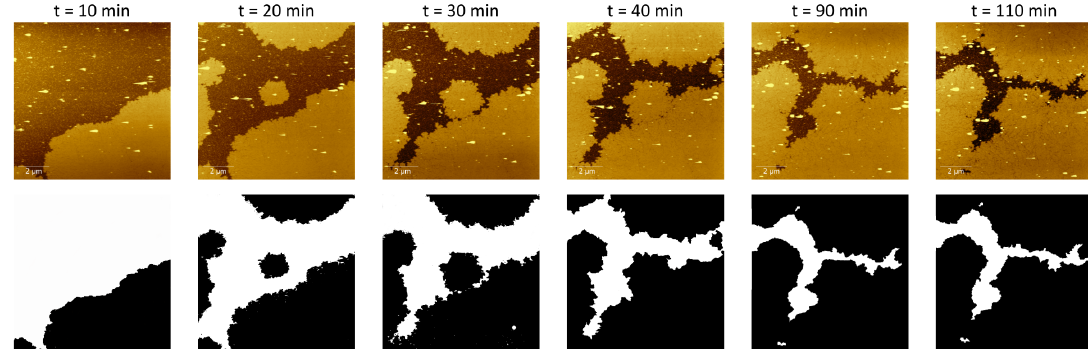
Figure 8. SbpA crystal growth sequence at different times. After the last time stamp at t = 110 min, the crystal was stabilized, growing very slowly until the complete filling of the substrate more than 12 h after the